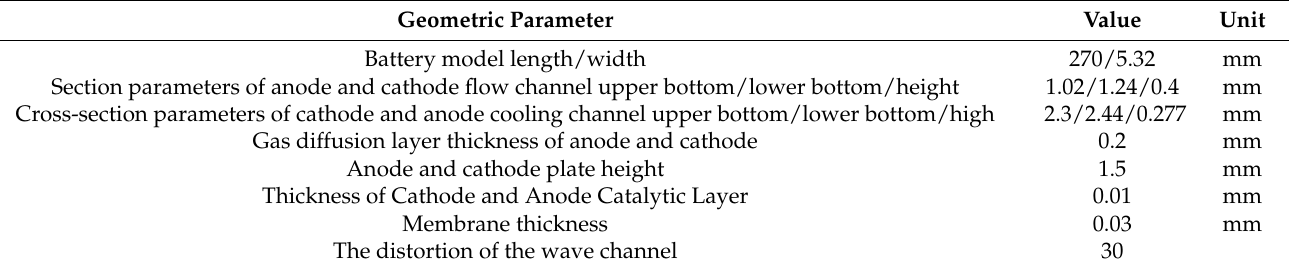
Table 1. Geometric model parameters of fuel cell.